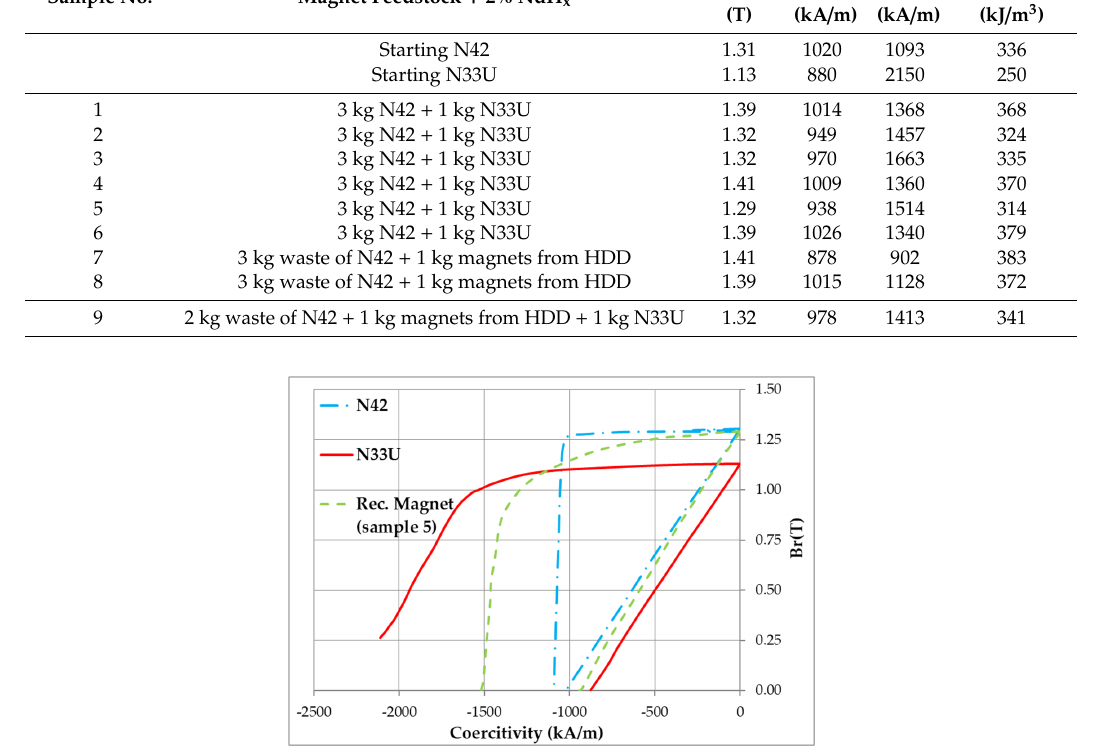
Table 3. Magnetic properties of Nd-Fe-B-based magnets prepared by recycling. Sample No. Sample